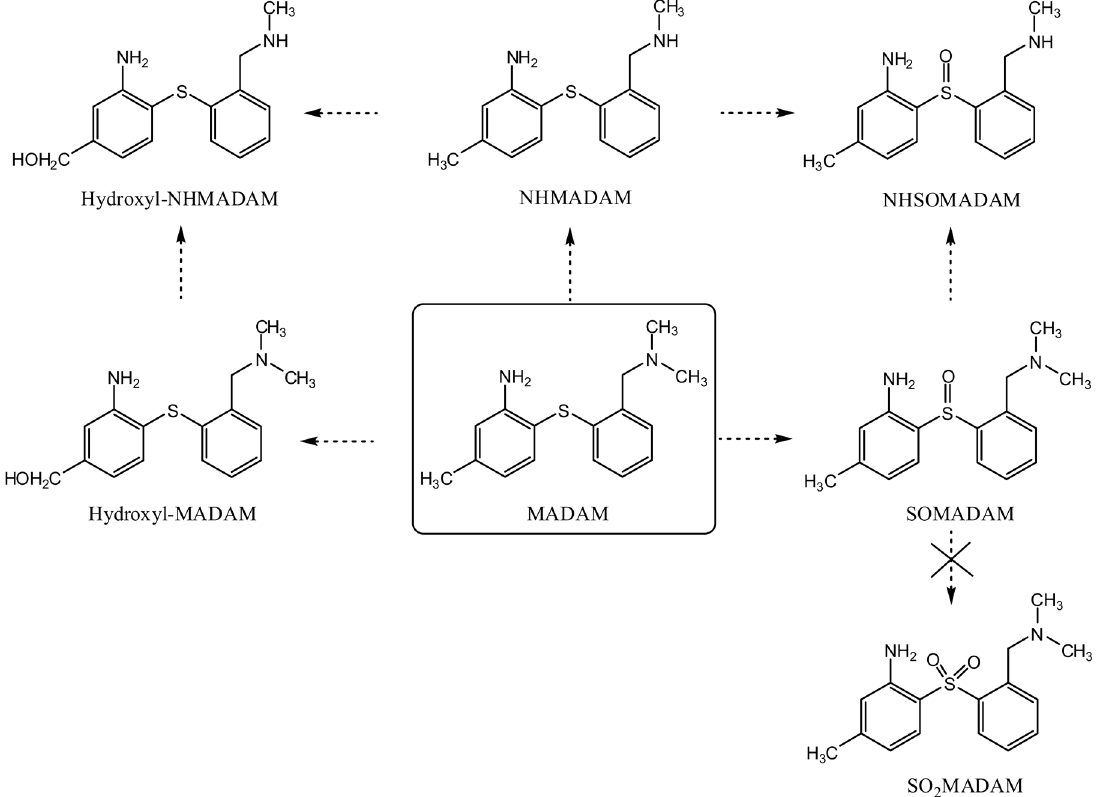
Fig 4. Proposed in vitro metabolic pathways of